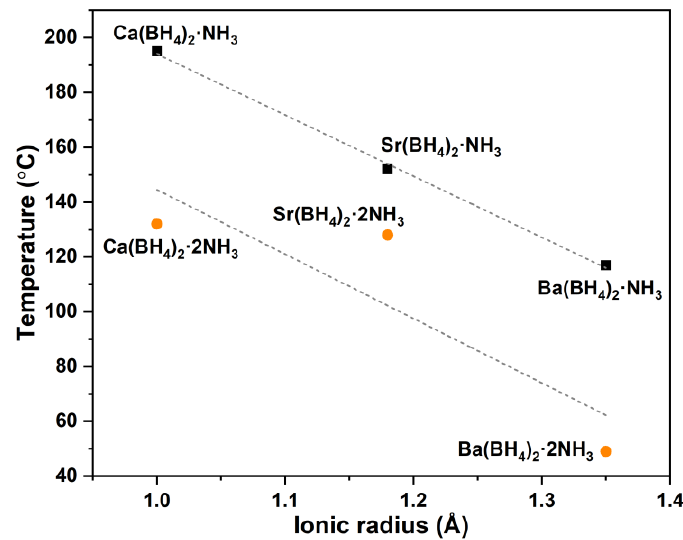
Figure 8. Decomposition temperatures for M (BH 4 ) 2 · x NH 3 ( M = Ca 2+ , Sr 2+ , Ba 2+ and x = 1, 2) [25]. The